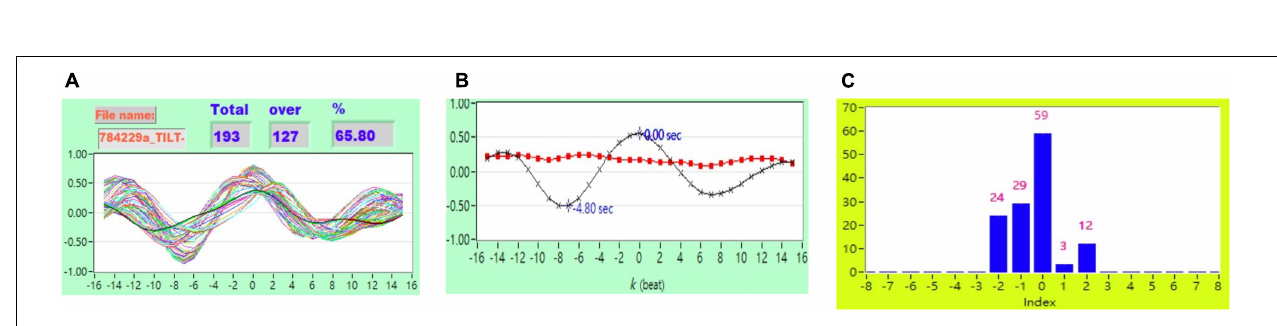
FIGURE 4 | (A) Representative plot of CCF curves with thresholding [–5 (cid:53) k (cid:53) 5 and CCF(k) > 0.3], (B) mean CCF value ( x ) and SD ( (cid:4) ), and (C) distribution bar chart of maximum CCF index during tilt in a healthy subject.